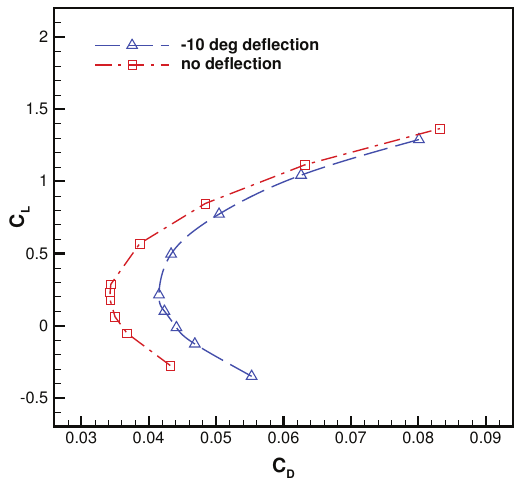
Figure 26. Elevators: drag polar for δ e = − 10 ◦ , compared to clean configuration.